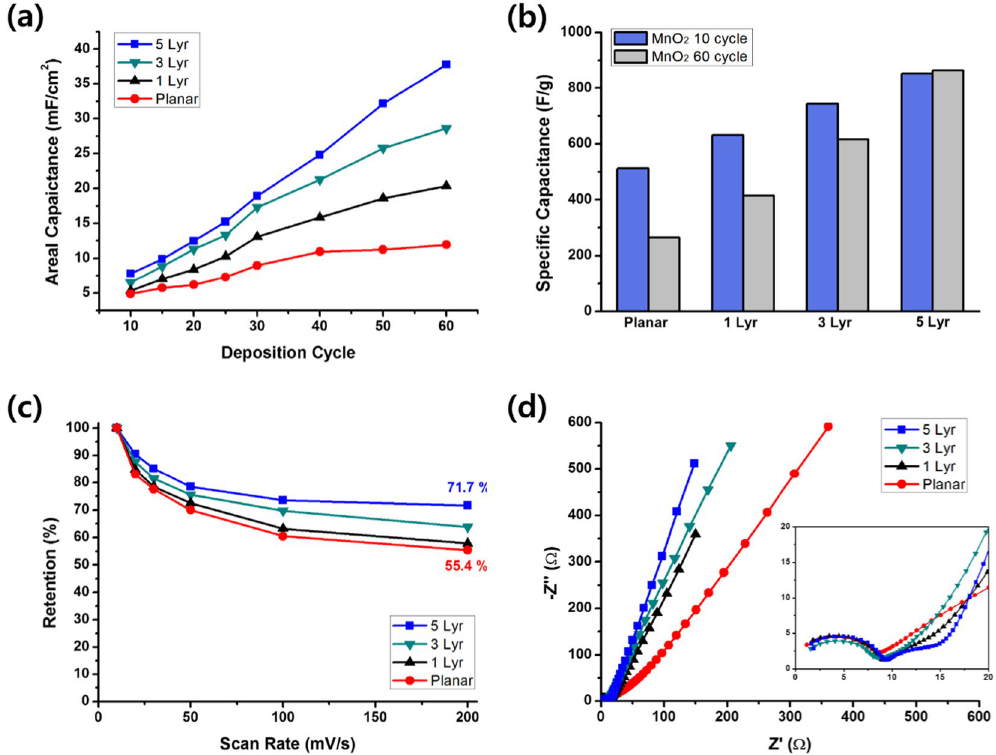
Figure 4. Electrochemical characterization of MnO 2 electrodes at various numbers of electrodepoistion cycles and scan rates. ( a ) Plots of the areal capacitance as a function of the number of MnO 2 electrodeposition cycles and ( b ) bar graphs of the specific capacitances after 10 and 60 electrodeposition cycles. The scan rate was 100 mV s − 1 for these measurements. ( c ) Plots of specific capacitance retentions as a function of the scan rate and ( d ) Nyquist plots for the planar and nanostructured electrodes. The number of MnO 2 electrodeposition cycles was 60 for these